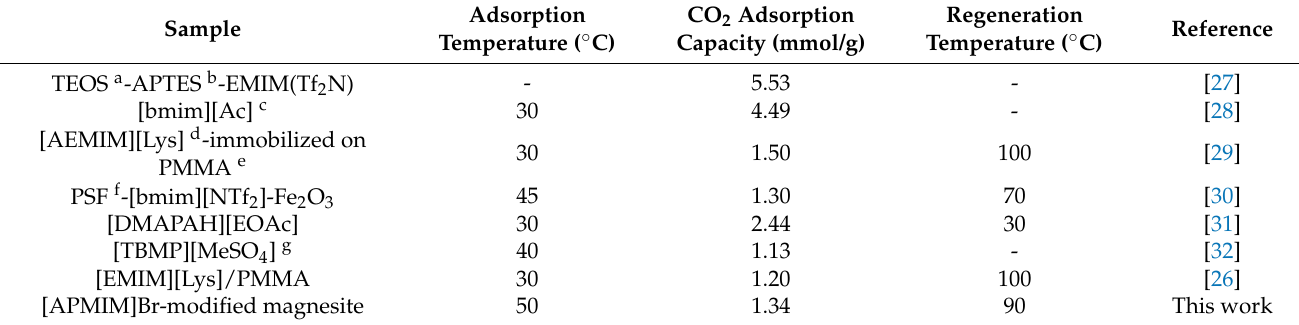
Table 2. Comparison of CO 2 capacity and regeneration condition of ILs-based